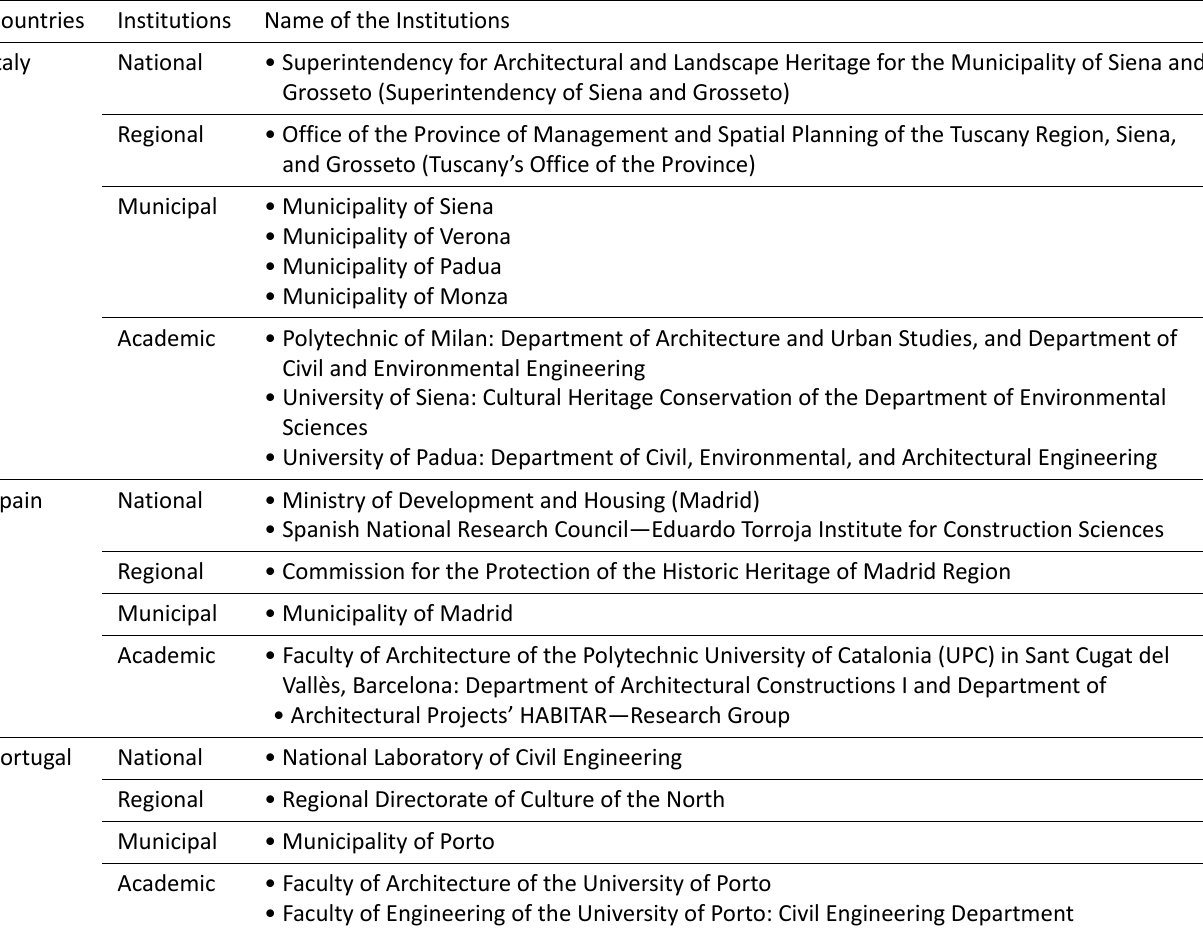
selected. The main procedures and criteria correspond‐ ing to the different levels of safeguarding and interven‐ tion in urban heritage were identified. Hence, the arti‐ cle presents the most representative rules and regula‐ tions of the three countries at the national level as well